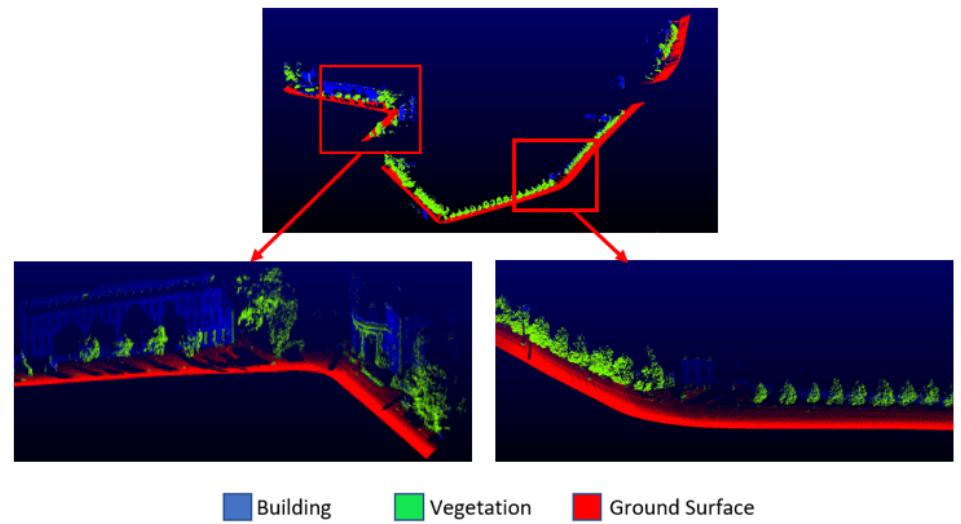
Table 6. The overall accuracy of the methods in Oakland3D. The highest-obtained accuracies are shown as bold.